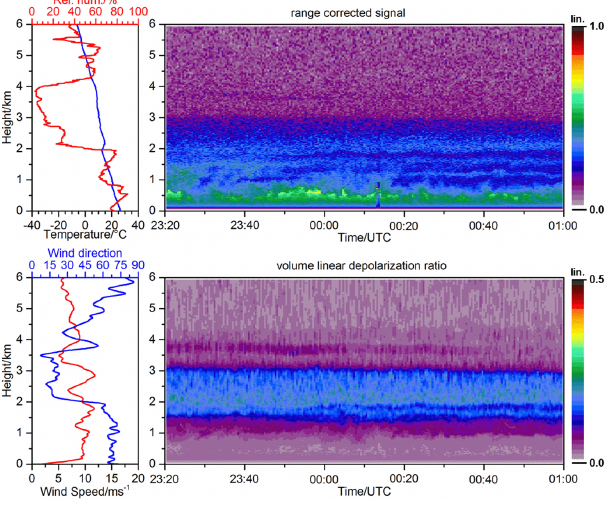
Figure 4. Radiosonde measurements of temperature and relative humidity (upper left panel) and of wind speed and wind direction (lower left panel) and lidar measurements of the range-corrected signal (upper right panel) and of the volume linear depolariza- tion ratio (lower right panel) at 532nm between 20 June 2013, 23:00UTC, and 21 June 2013, 01:00UTC. The radiosonde was launched on 21 June at